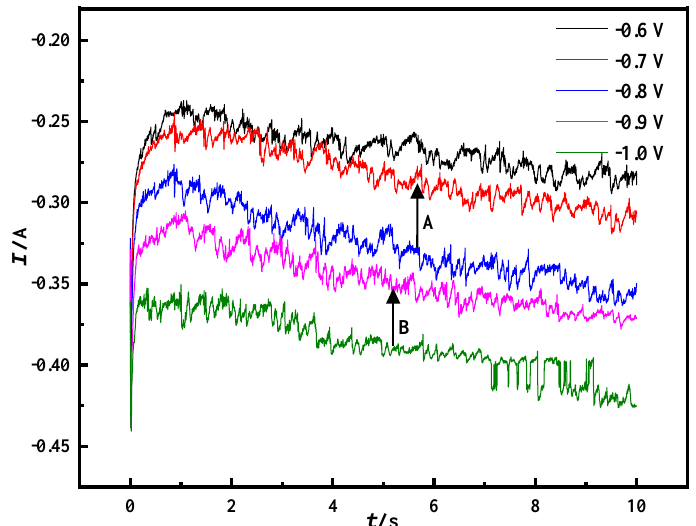
Figure 7. Cyclic voltammetry curve of Mo electrode in NaCl-CaCl 2 -LiNiO 2 molten salt system (scan- ning speed: −0.6-−1.0 V/s, T = 750 °C, reference electrode: Pt electrode). (scanning speed: − 0.6– − 1.0 V/s, T = 750 ◦ C, reference electrode: Pt